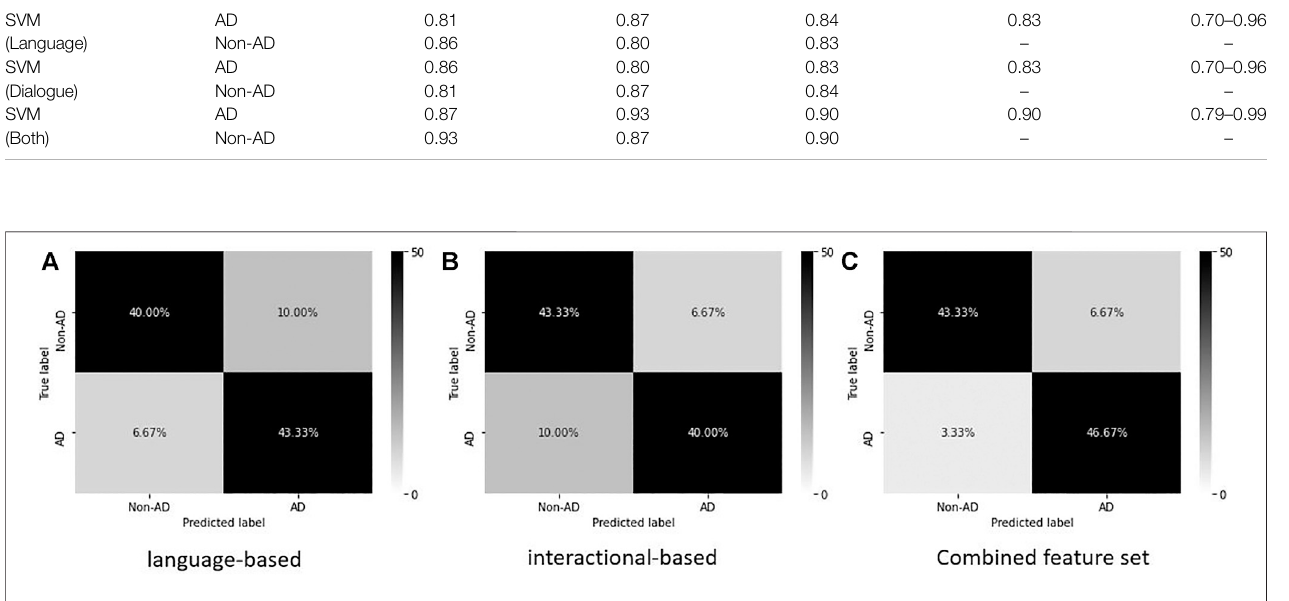
FIGURE 3 | Confusion matrices for AD classi fi cation task with different feature